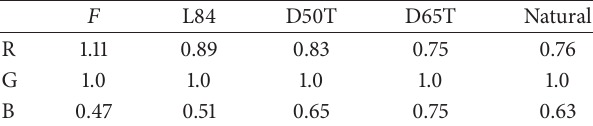
Figure 2: Spectral characteristics of Aptina MT9P031 CMOS sensor [19]. Table 1: Mean value of different color channels for Figure